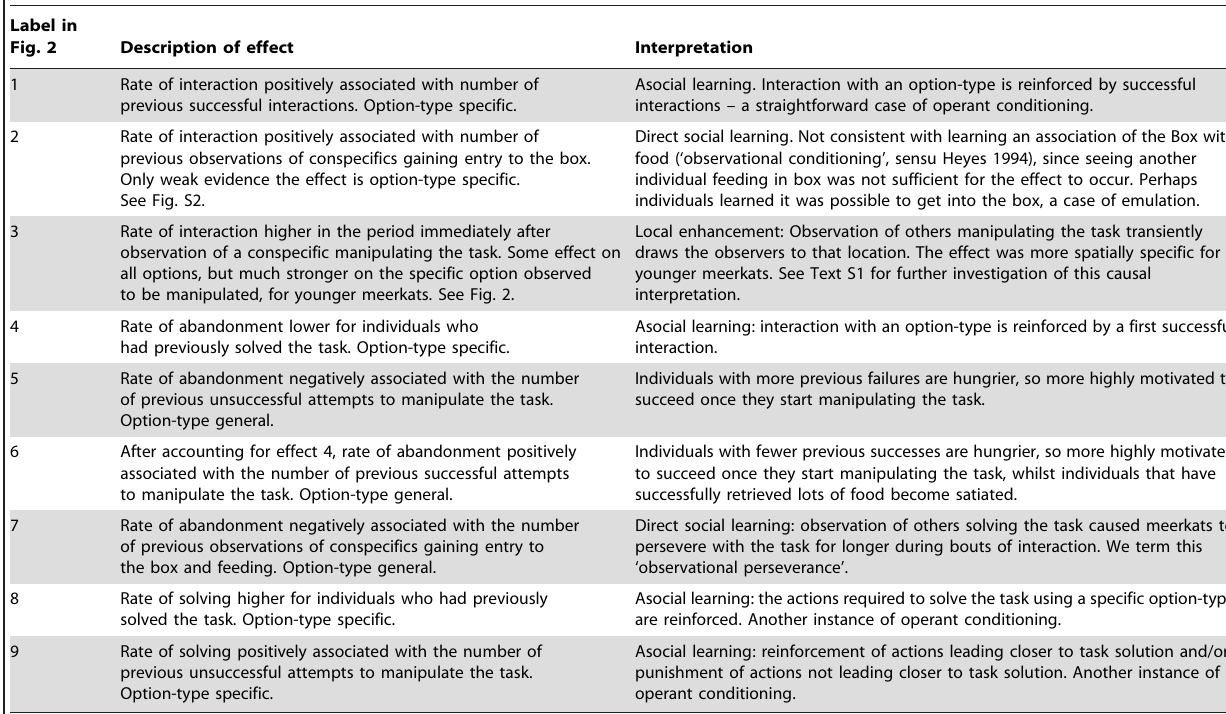
Table 1. Summary of effects found on meerkats’ task solving behaviour, and our interpretation.